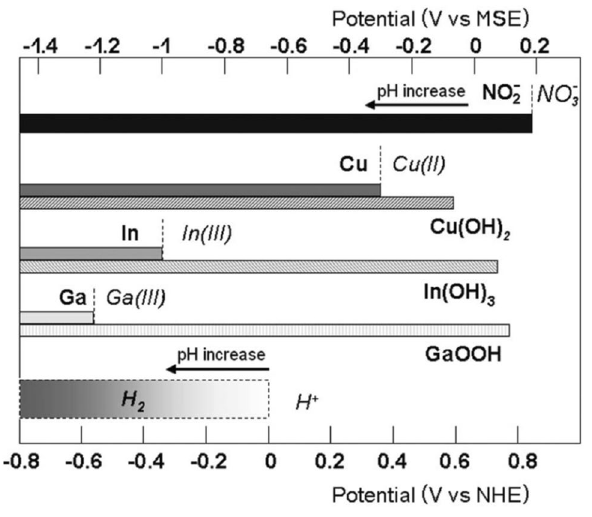
Fig. 4 Comparative diagram of the standard deposition potentials of copper, indium and gallium in the form of metals or hydroxide/oxide during nitrate reduction. Reprinted with permission from Duchatelet et al. [63]. Copyright 2014, The Electrochemical Society